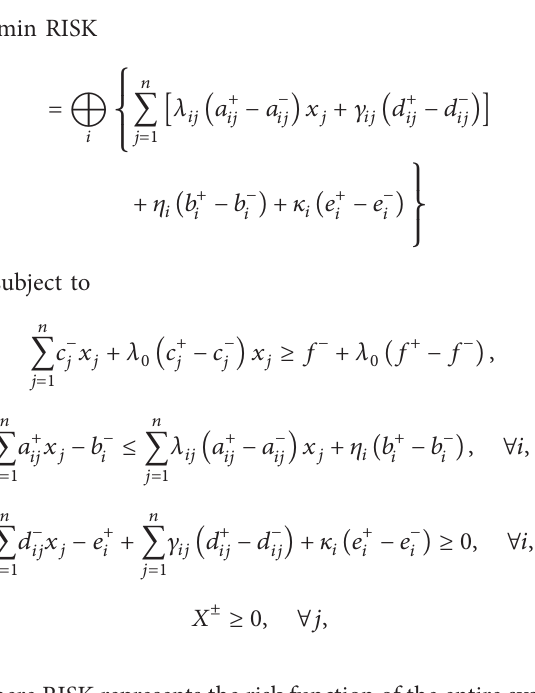
Figure 2: Solution steps of risk explicit interval linear programming